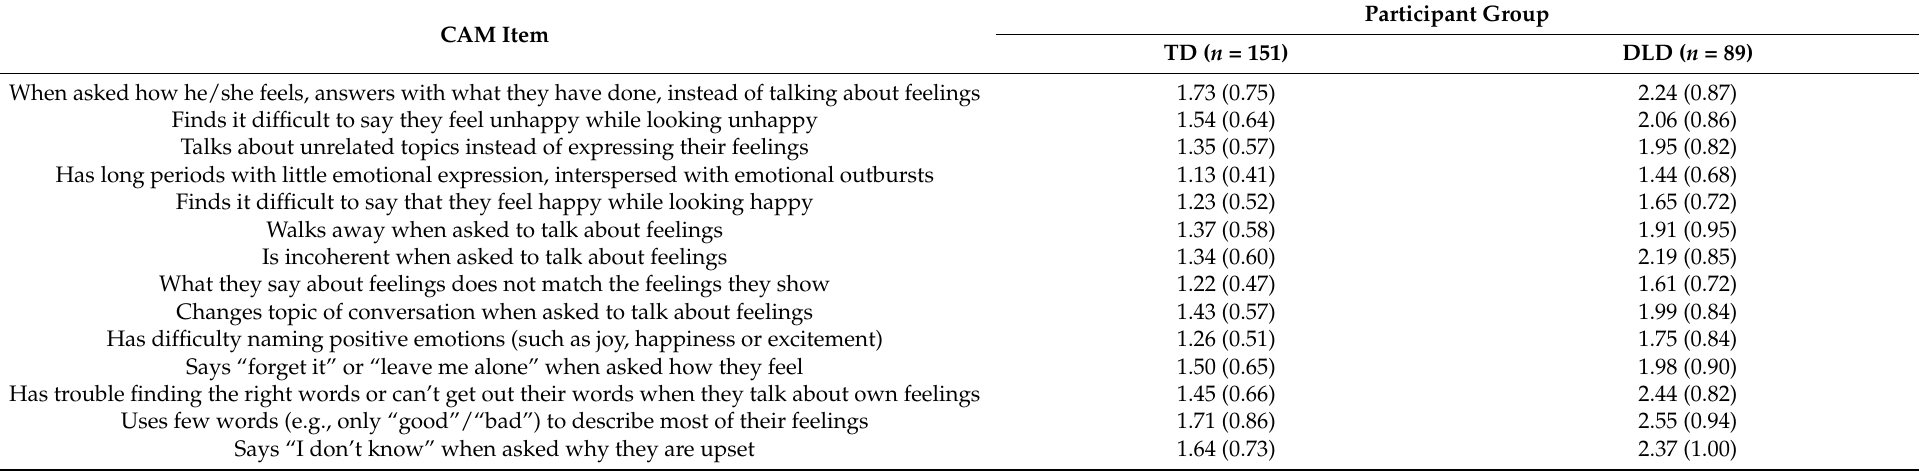
Table 2. Means and SDs for CAM items.